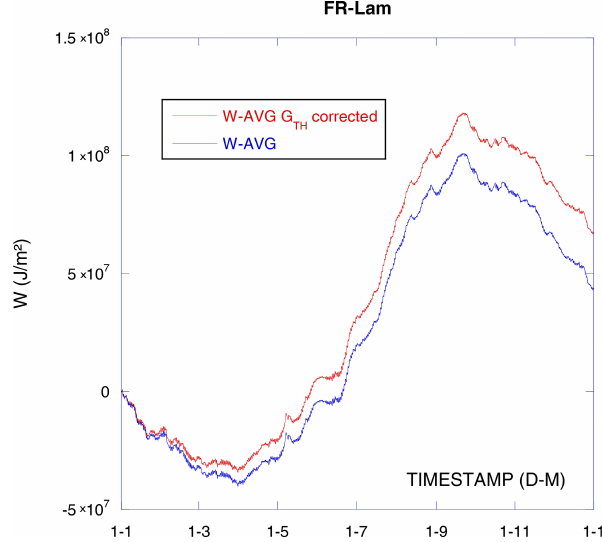
Figure 8. Integrated factor of precipitation with soil surface tem- perature difference with soil 5cm depth temperature.